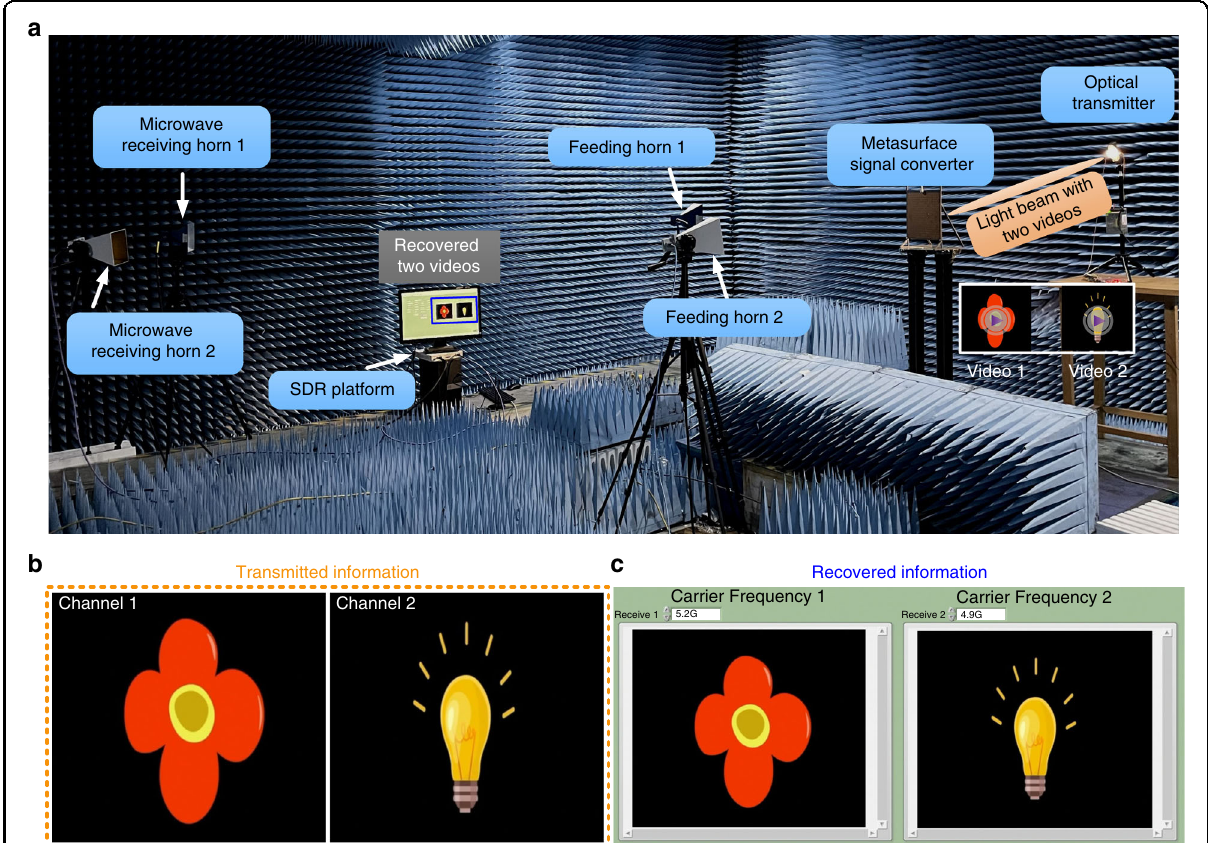
Fig. 4 Experimental demonstration of the dual-channel hybrid communication system based on the metasurface-enabled light-to- microwave transmitter. a Photograph of the experiment setup. The hybrid communication system contains an optical transmitter, a metasurface signal converter, and a microwave receiver, in which two different videos can be transmitted and received simultaneously and independently in a light-to-microwave wireless link. b , c The original transmitted information of the fl ower blooming and the bulb glowing ( b ), and the corresponding recovered information ( c ),